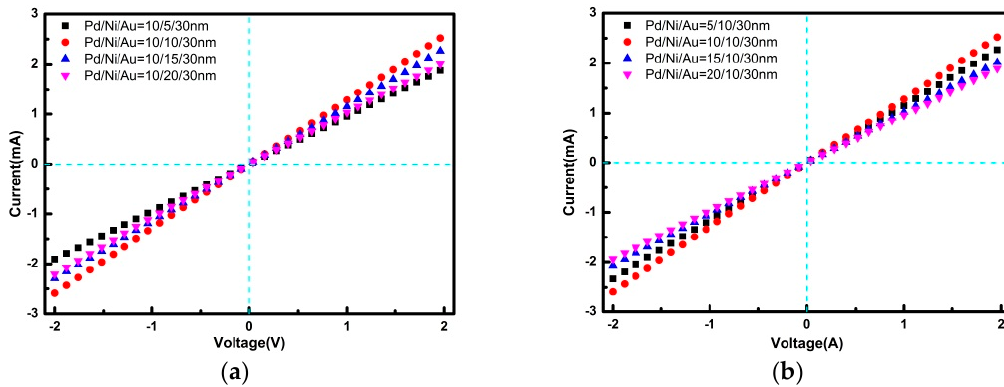
Figure 7. I – V characteristics of Pd/Ni/Au contacts on GaN laser diodes alloyed at different Ni or Pd thicknesses: ( a ) Different Ni thicknesses in Pd/Ni/Au contacts; ( b ) different Pd thicknesses in Pd/Ni/Au contacts.